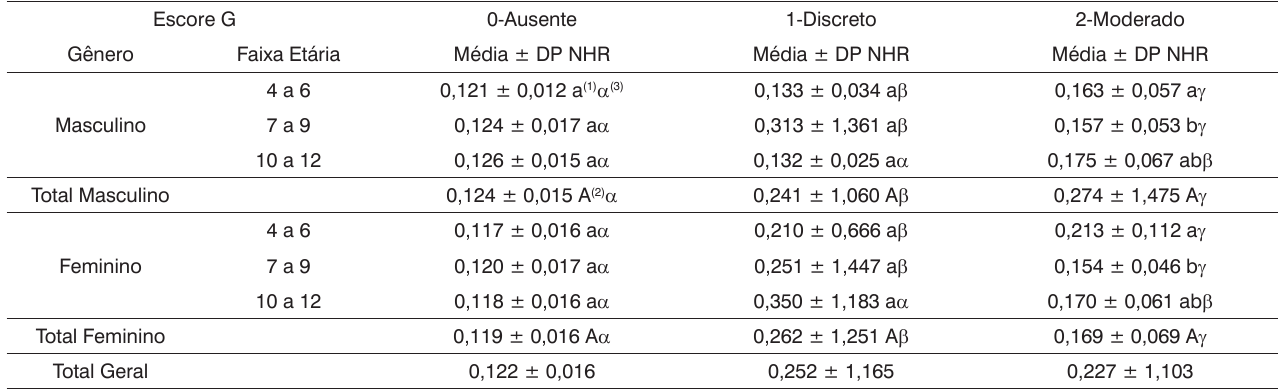
Tabela 11. Valores médios e desvio padrão (DP) de NHR e correlação com o escore do parâmetro G da escala GRBASI, o gênero e a faixa etária (em anos).